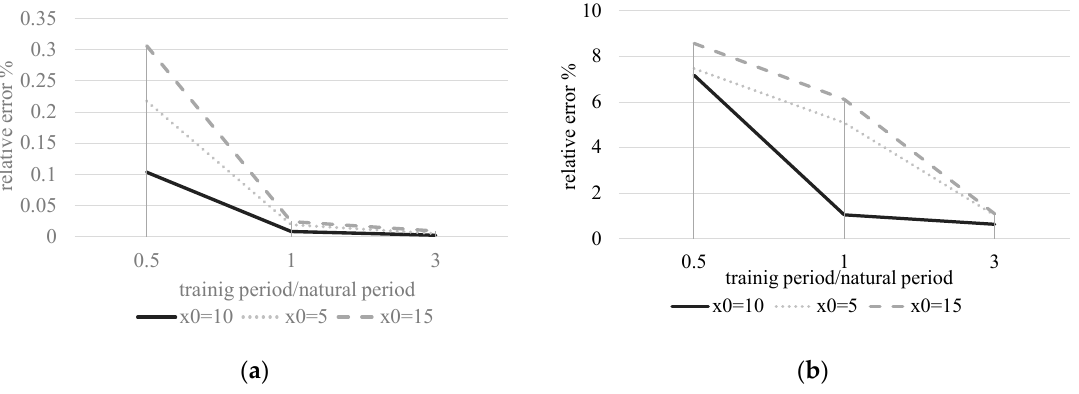
Figure 6. PINN’s relative error with different training periods for ( a ) natural circular frequency; ( b ) damping ratio estimations.